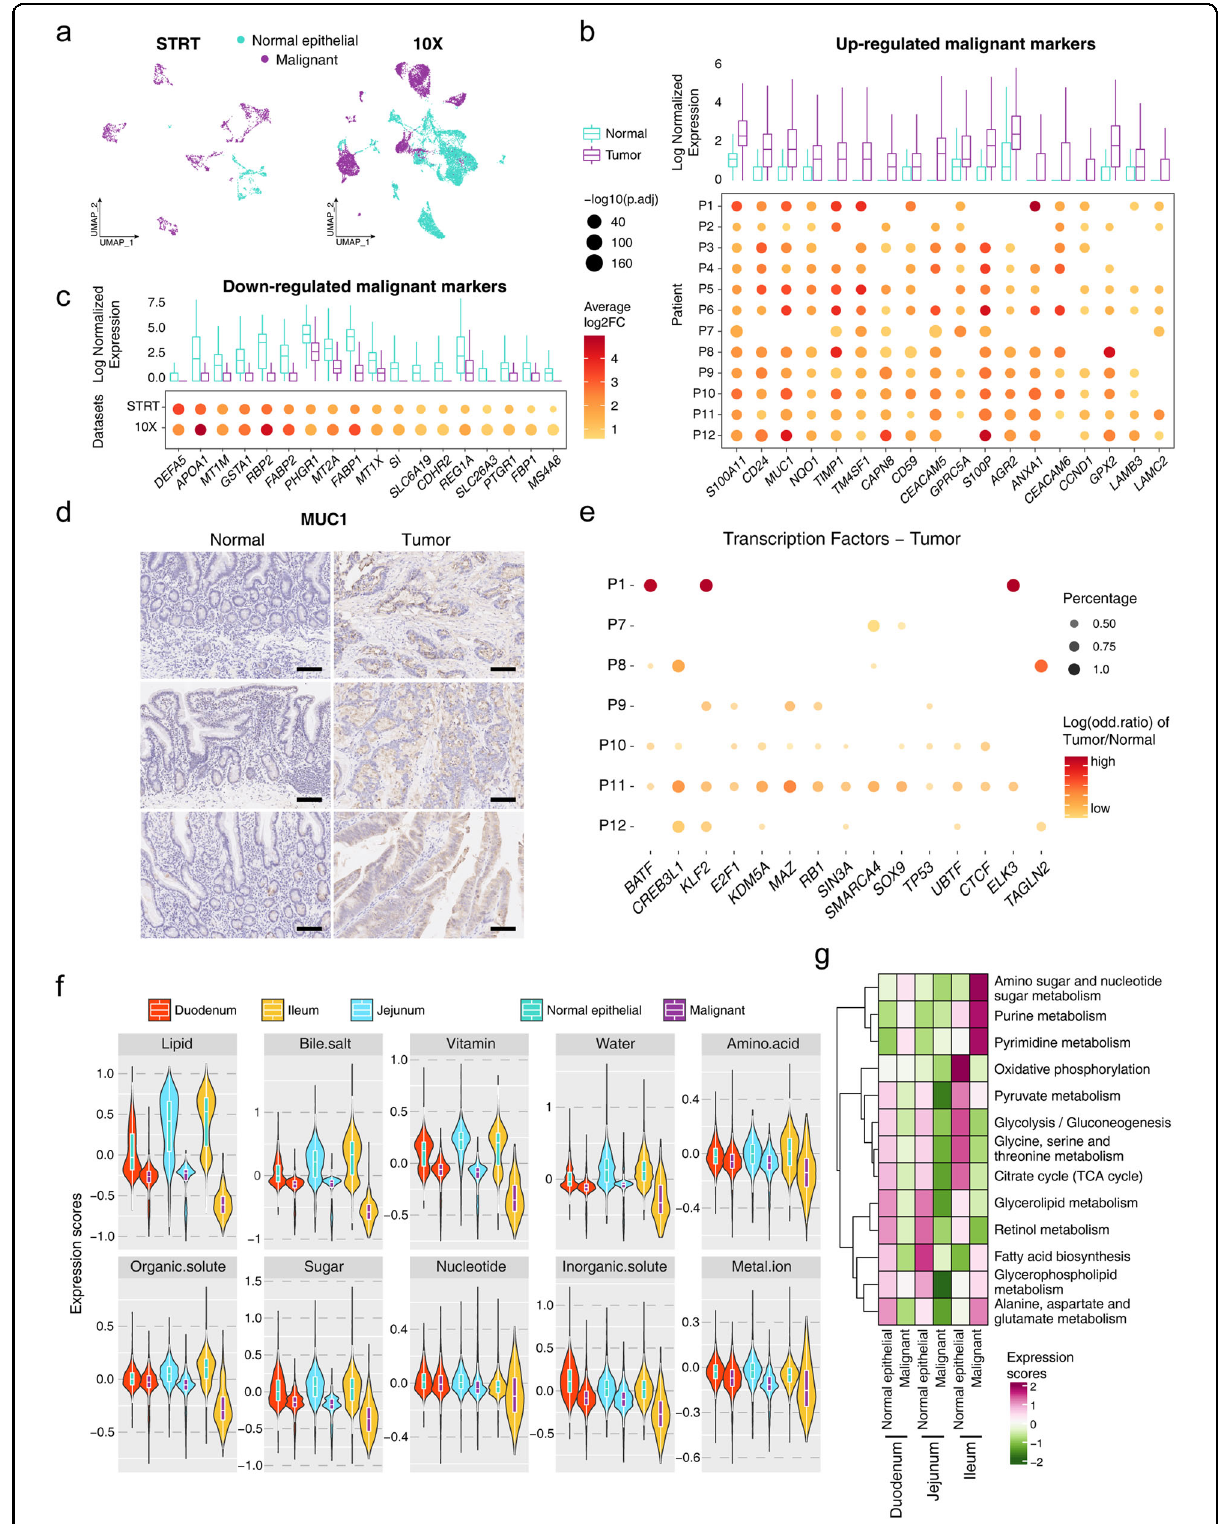
Fig. 2 (See legend on next